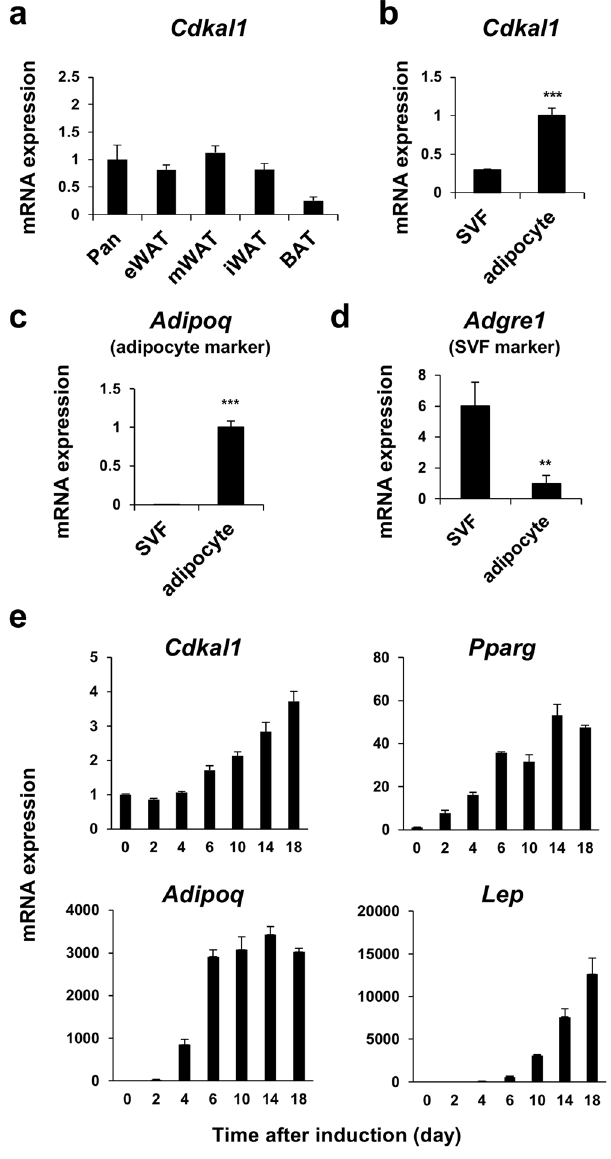
brown adipose tissue; Panc, pancreas (n = 4 [BAT], 7 [Pancreas] or 8 [(others]). Expression of Cdkal1 ( b ), Adipoq ( c ) and Adgre1 ( d ) in the stromal vascular fraction (SVF) and adipocytes fraction isolated from eWAT of C57BL/6 J mice (n = 4, ** p < 0.01, *** p < 0.001 vs SVF group by Student’s t-test). ( e ) Gene expression levels during adipocyte differentiation of 3T3-L1 cells: upper left, Cdkal1; upper right, Pparg; lower left, Adipoq; lower right, Lep (n =